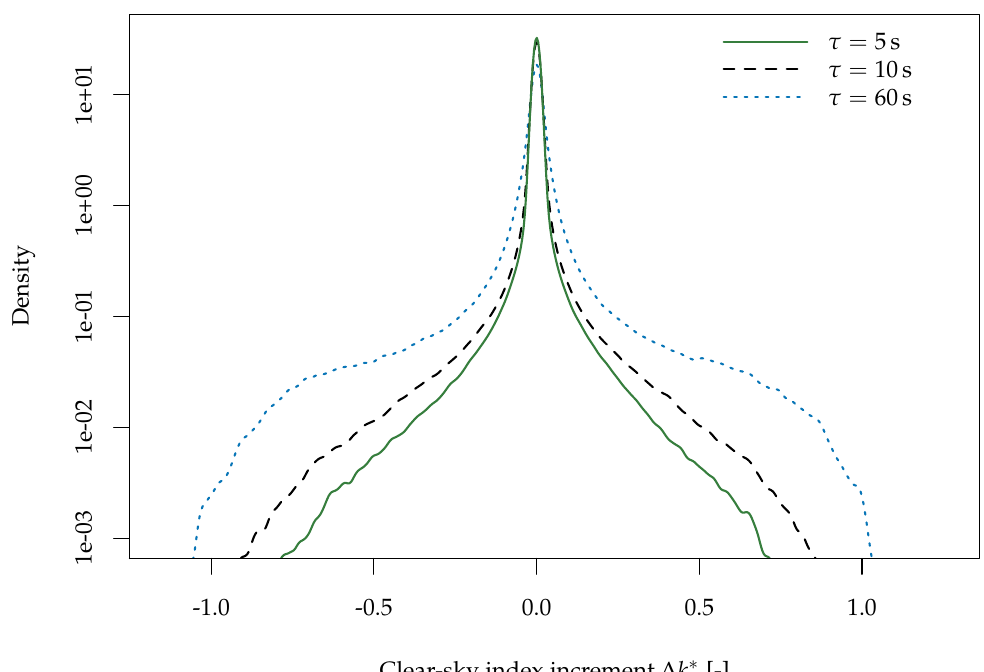
10 6 s worth of ·